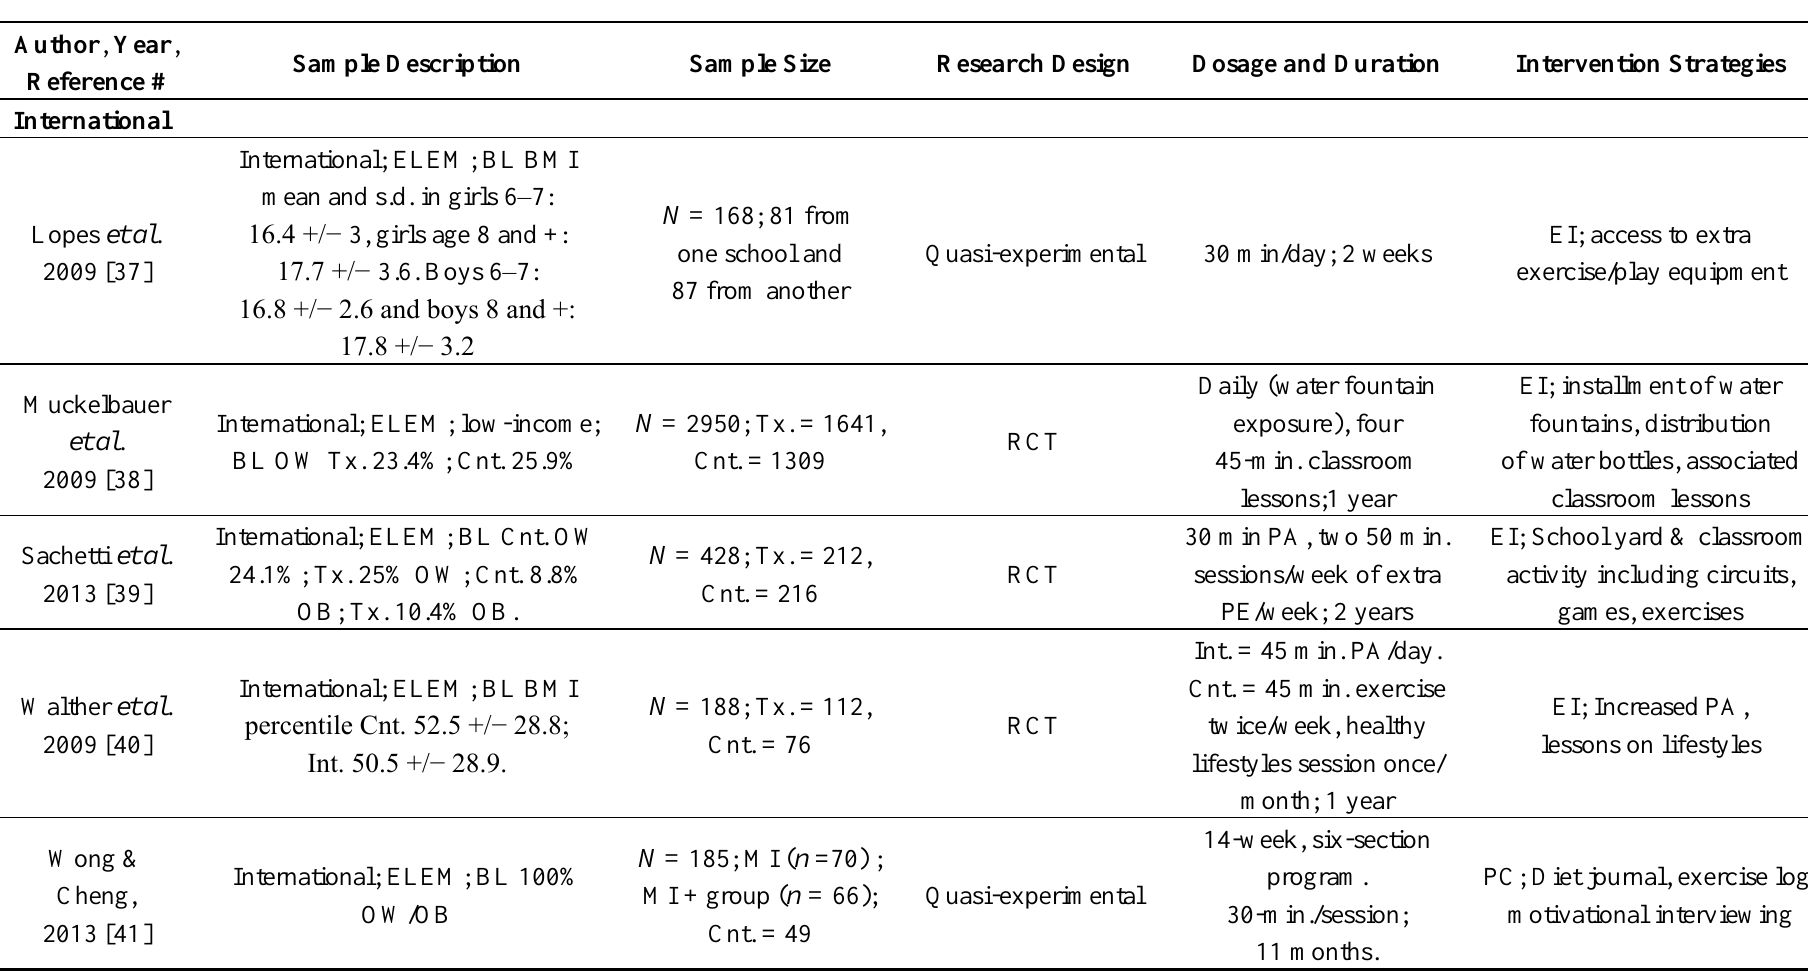
Table Key: BL=Baseline; CR= Culturally relevant; EI= Environmental Influence; ELEM=Elementary; OB = Obese; OW = Overweight; PA=Physical activity; PC= Parental